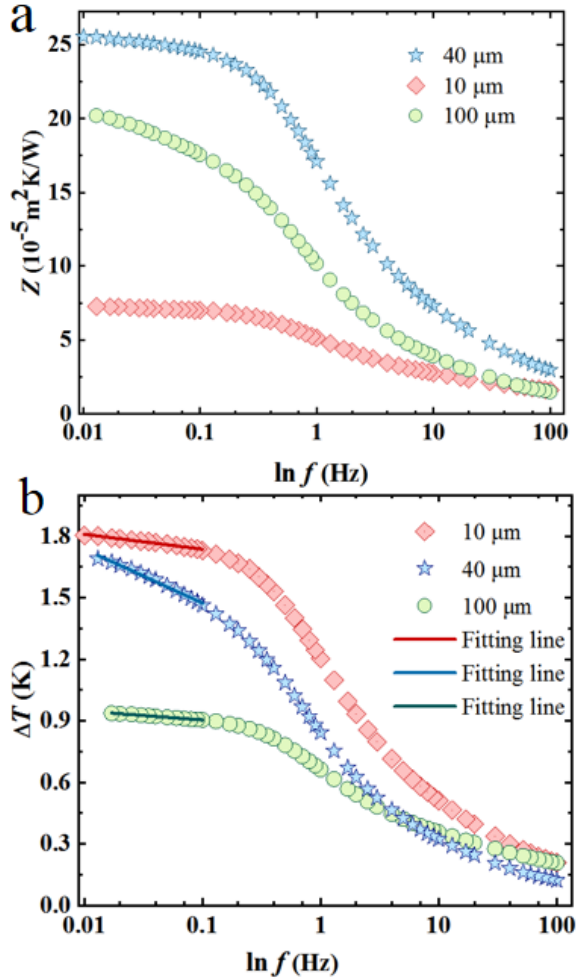
Figure 2. ( a ) The thermal impedance versus the logarithmic frequency. ( b ) The fitted results of temperature rise as a function of